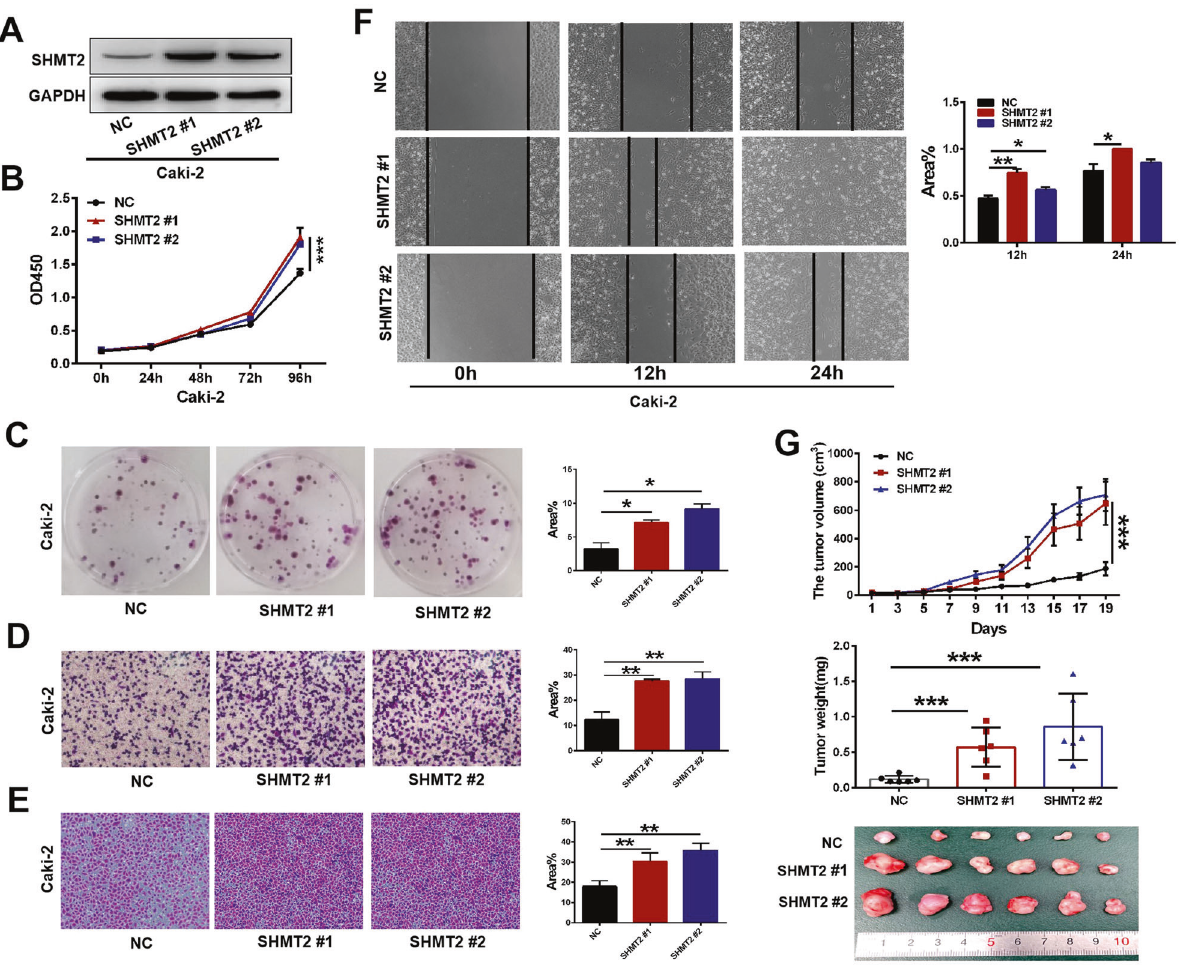
Fig. 3 Effects of SHMT2 overexpression on proliferation and metastasis in ccRCC cells. Lentivirus encoding empty vector or SHMT2 vector were infected into Caki-2 cells. A Western blot analysis was performed to evaluate the SHMT2 protein levels in empty vector control (NC) or SHMT2 #1/#2 overexpression cells. B Cell proliferation assay of Caki-2 cells stable transfected with NC or SHMT2 #1/#2. Error bars represent SD ( n = 3). C Colony formation assays of Caki-2 cells stable transfected with NC or SHMT2 #1/#2 for 10 days. D , E Cell migration ( D ) and invasion ( E ) assays of Caki-2 cells stable transfected with NC or SHMT2 #1/#2. F Would healing assay of Caki-2 cells stable transfected with NC or SHMT2 #1/#2. G The tumor volume, weight, and images of NC and SHMT2 #1/#2 Caki-2 xenograft in nude mice. Tumor sizes were measured every 2 days for total 19 days (top panel). Tumor weights were measured after dissection (middle panel). Tumor images were taken after dissection (bottom panel). Data were represented as mean ± SD. * P < 0.05, ** P < 0.01, *** P <